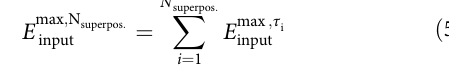
¼ 7 delay superpos :